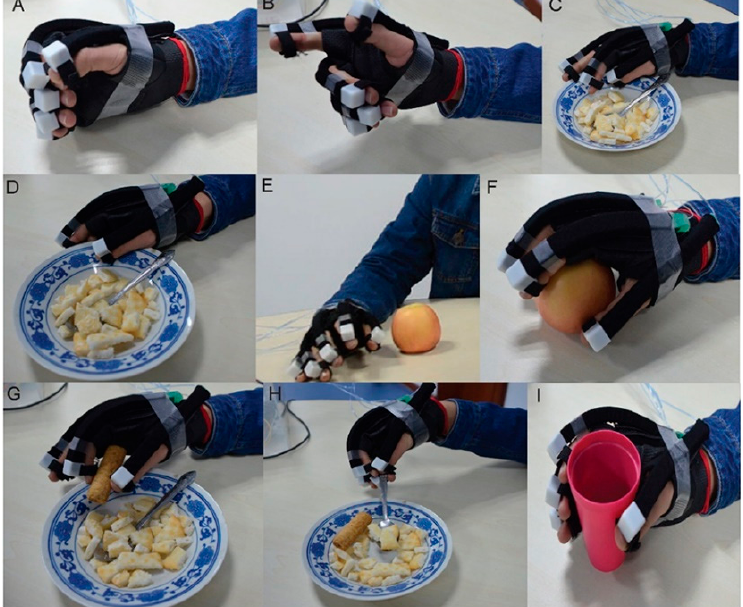
Figure 9. ( A – I ) are the results presentation of the hand action. As an example, A is grasping various objects in their everyday life quickly according to his/her intention with the help of a soft robot [100].